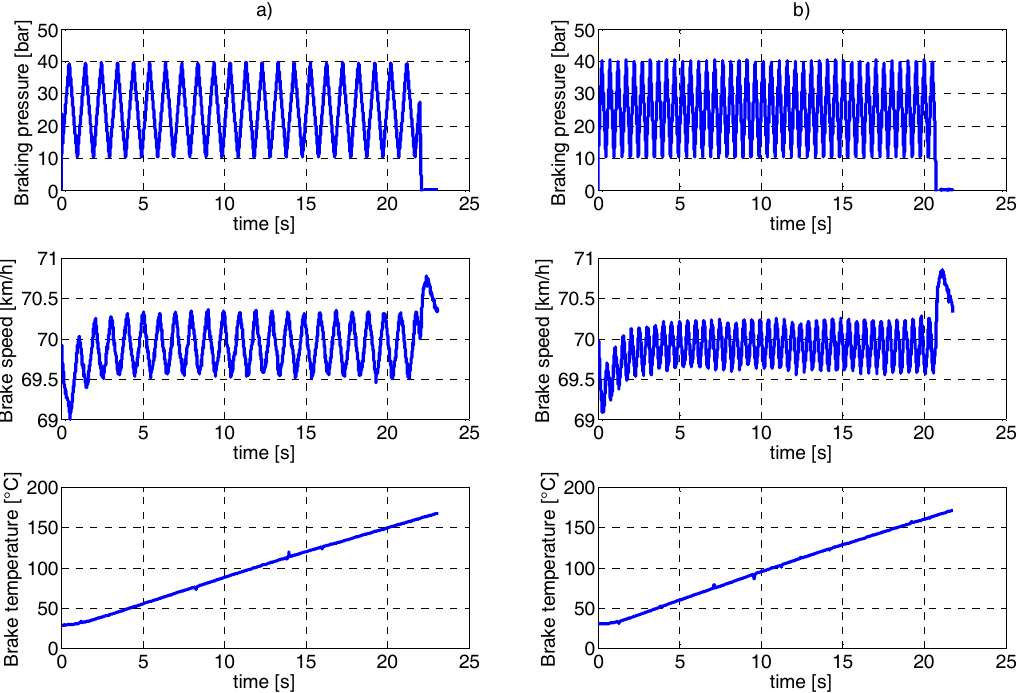
Figure 4. Experimental measurements on the brake test rig performed at TU Ilmenau. Datasets ( a ) and ( b ) have been used for the identification and validation procedures, respectively. Top row: the oscillating braking pressure, as an input of the system. Middle row: brake speed profile. Bottom row: brake temperature profile.